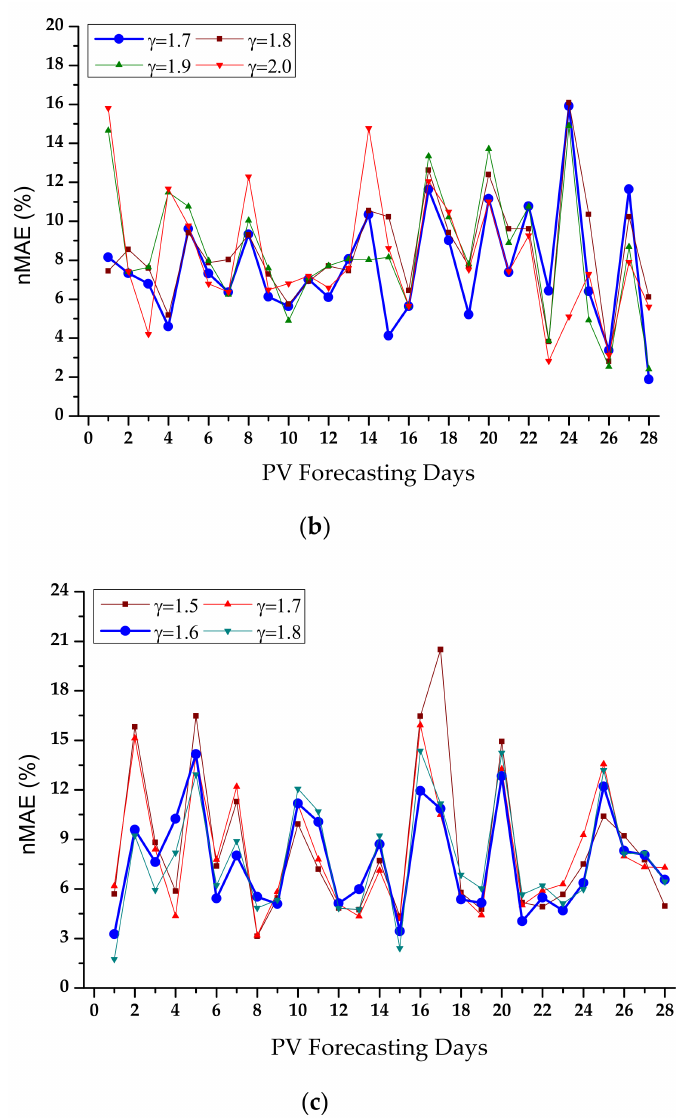
Figure 9. Results of PV power forecasting with di ff erent γ values. ( a ) Summer, ( b ) autumn, and ( c )